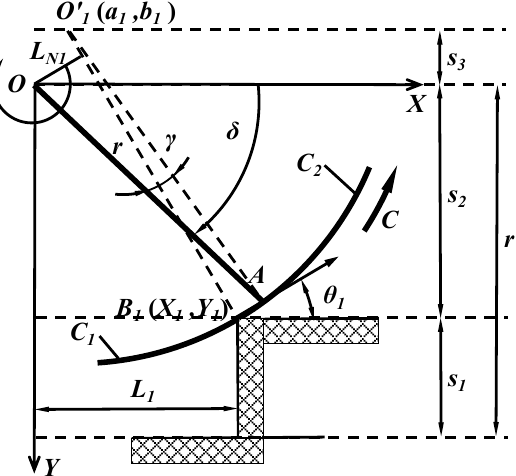
Figure 16. Drive force under transformable state C 1 and C 2 Q (15 mm) (Blue: wheel state; Red: C 1 ; Green: C 2 ).